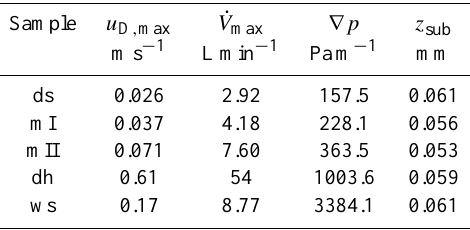
Table 2. Maximum flow rates, pressure gradients and minimum snow height for airflow saturation for different snow samples.